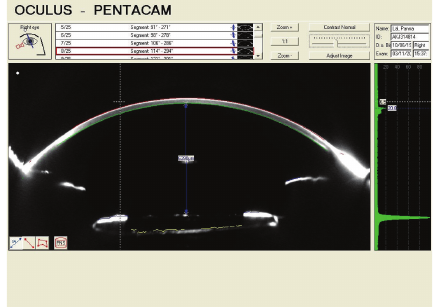
Figure 3: Scheimpflug image of the right eye after cataract surgery shows hyperdeep anterior chamber.